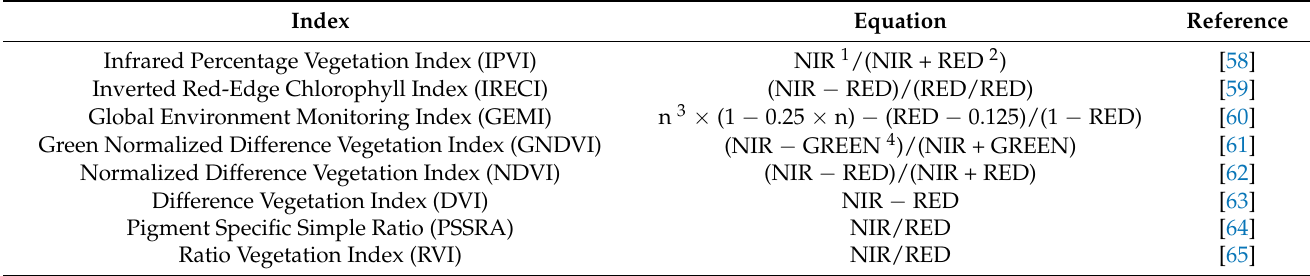
Table 1. Vegetation indices extracted from Sentinel-2